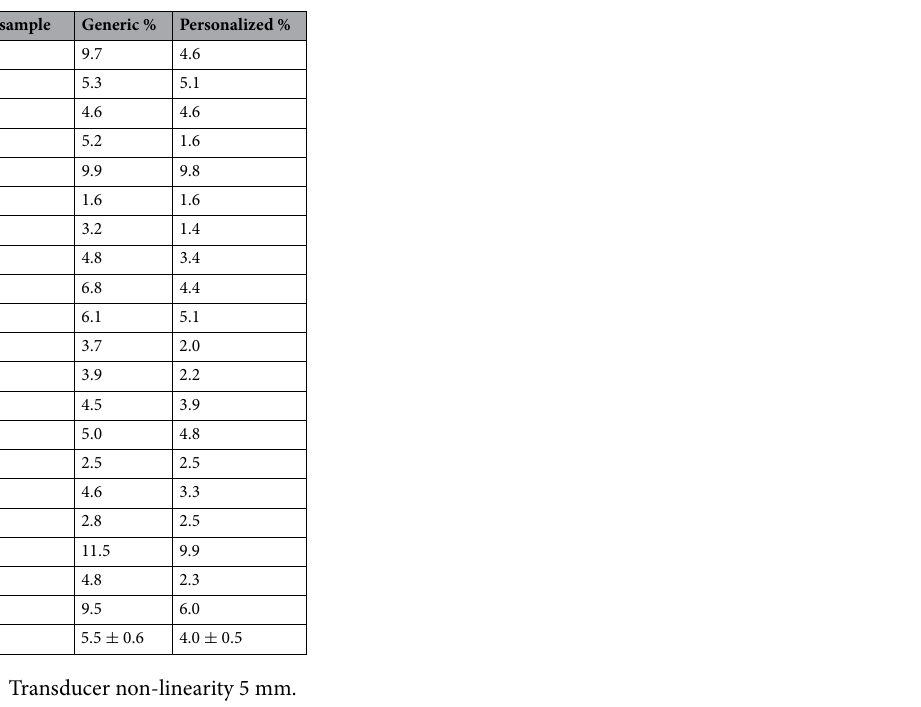
Table 1. Transducer non-linearity 5 mm.